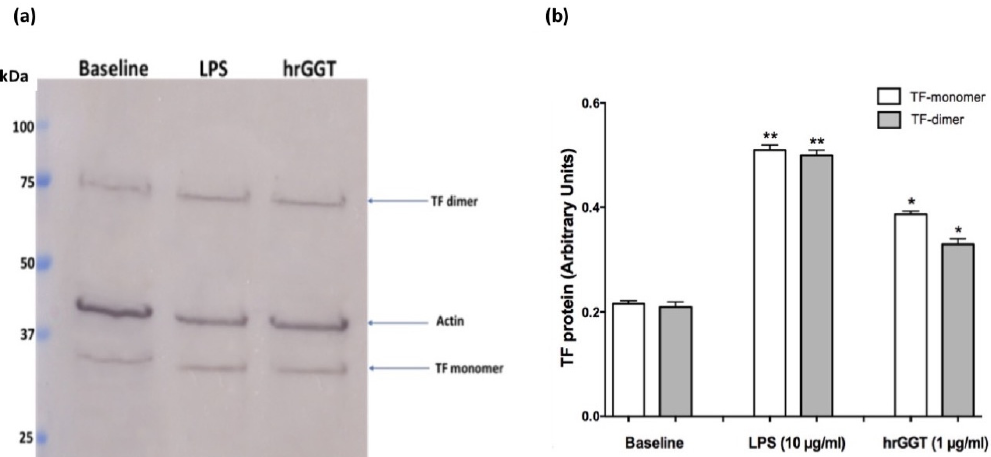
Figure 2. hrGGT induces TF protein expression in THP-1 cells. Panel ( a ) Representative western blot image of TF expression (monomers at ~35 kDa and dimers at ~75 kDa) in response to hrGGT (1 µg/mL). Panel ( b ) Semi-quantitative densitometric analysis (ImageJ software) of TF monomer and dimer expression. Data are reported in arbitrary units normalized to the corresponding β -Actin signals. LPS (10 µg/mL) was used as a positive control. Data are presented as mean ± SEM ( n = 3) for Western blot experiments. * p < 0.05 vs. the baseline; ** p < 0.01 vs. the baseline.